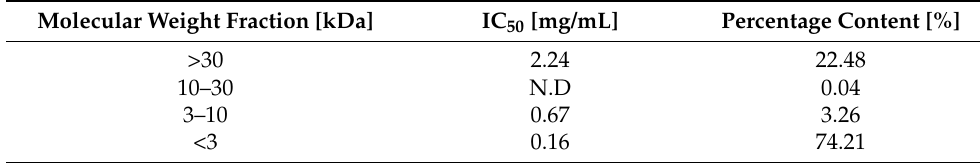
Table 1. IC 50 (Angiotensin-converting enzyme inhibitory activity) of. L. casei 001-fermented Hi- dakakombu by molecular